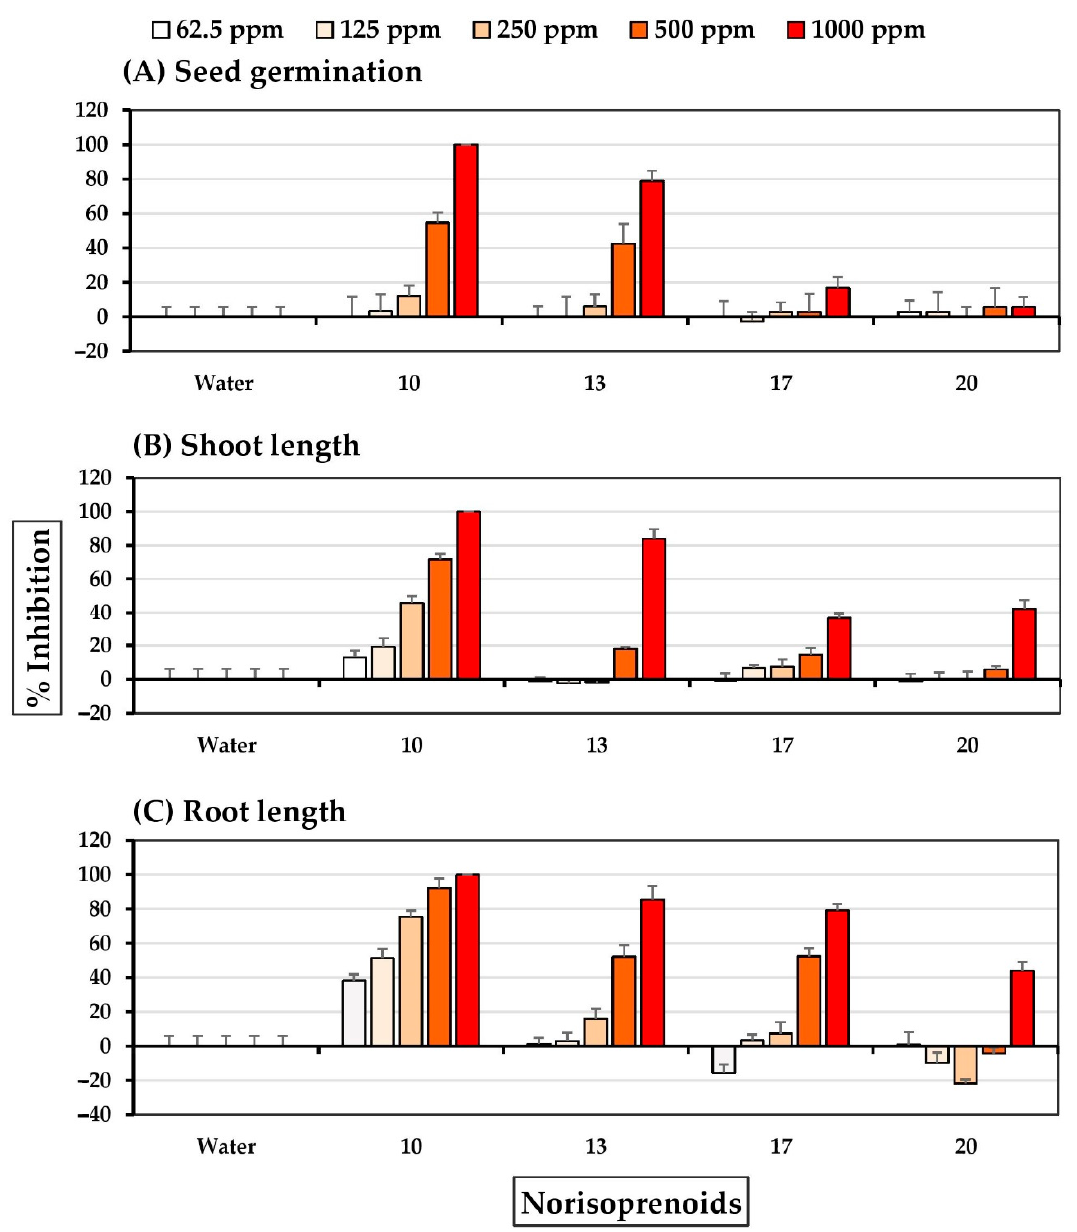
Figure 10. Inhibitory effects of norisoprenoids of S. platensis on ( A ) seed germination, ( B ) shoot length, and ( C ) root length of barnyardgrass. Distilled water was used as a